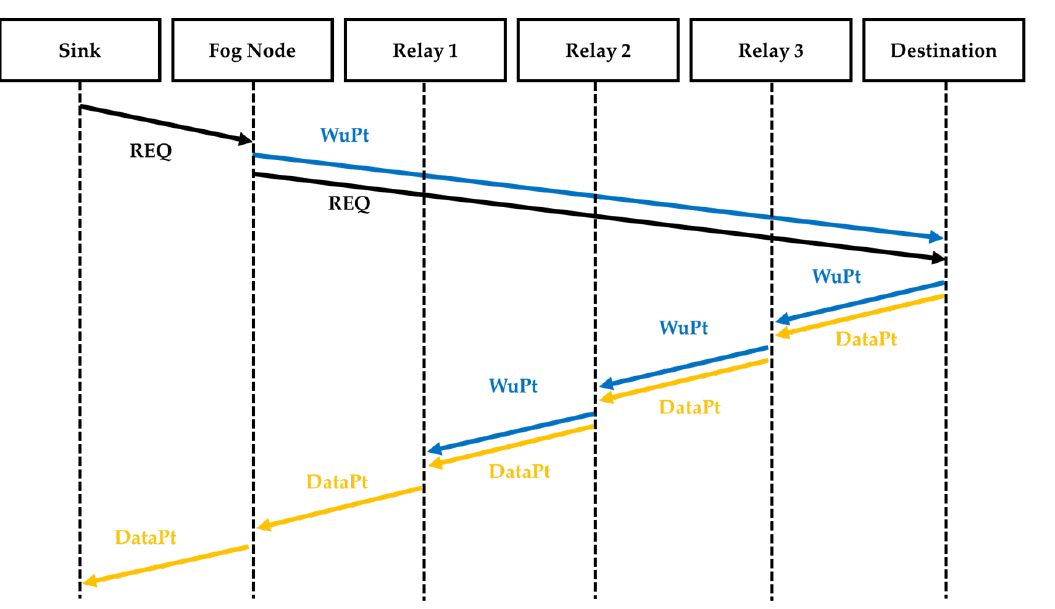
Figure 9. Sequence diagram of NTN approach.